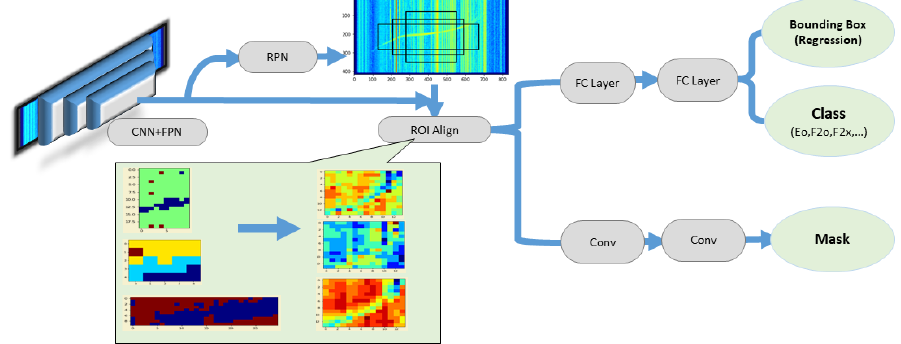
Figure 3. The architecture of Mask